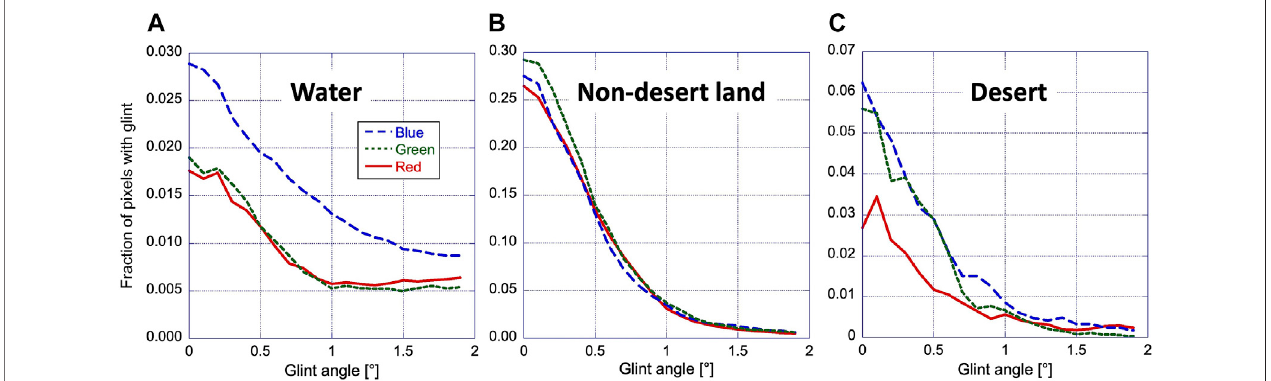
FIGURE4| Fractionofallpixelsforwhichtheglintmaskindicatesthepresenceofglint,plottedseparatelyforeachsurfacetypeandEPICbandasafunctionofglint angle(theanglebetween theactual EPIC viewdirectionand the direction oflookingstraight intothe specular re fl ection from aperfectlyhorizontal surface).Asdiscussed in the text, the differences in glint detection frequency over various surface types come from a combination of differences in ice cloud populations and in glint detection sensitivity.